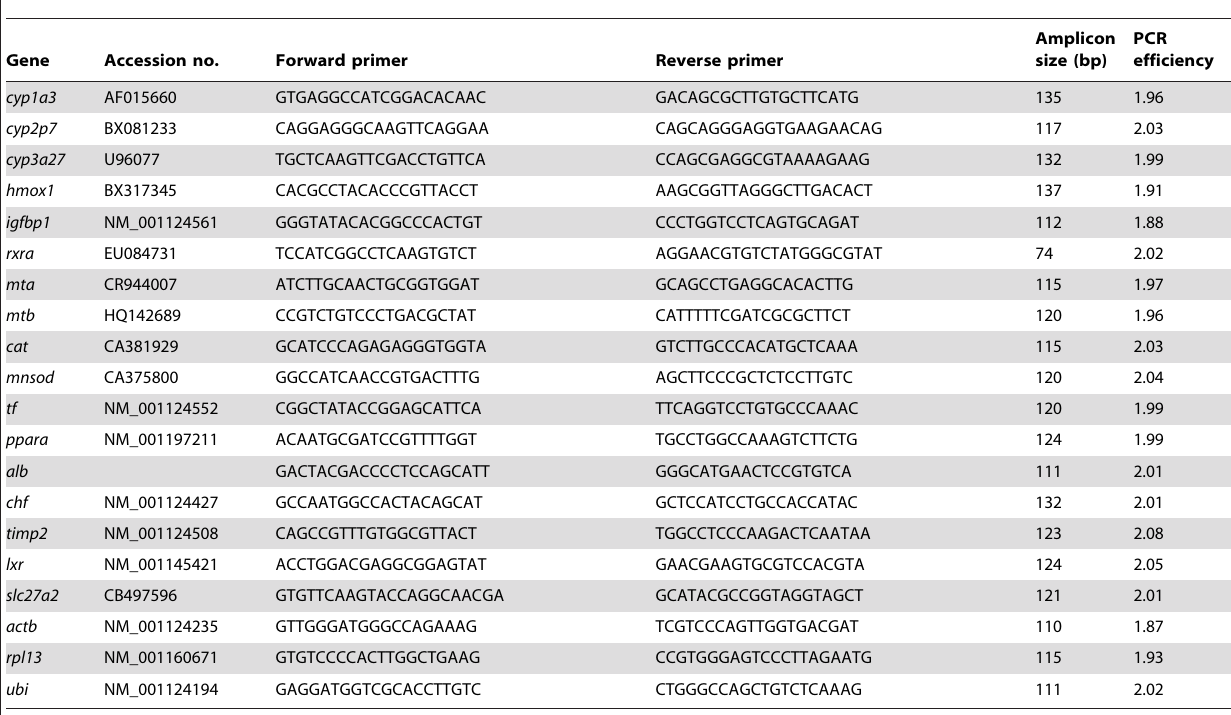
Table 3. PCR primers, accession numbers, amplicon sizes and PCR efficiencies.